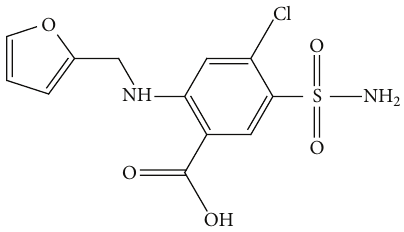
Figure 1: Chemical structure of